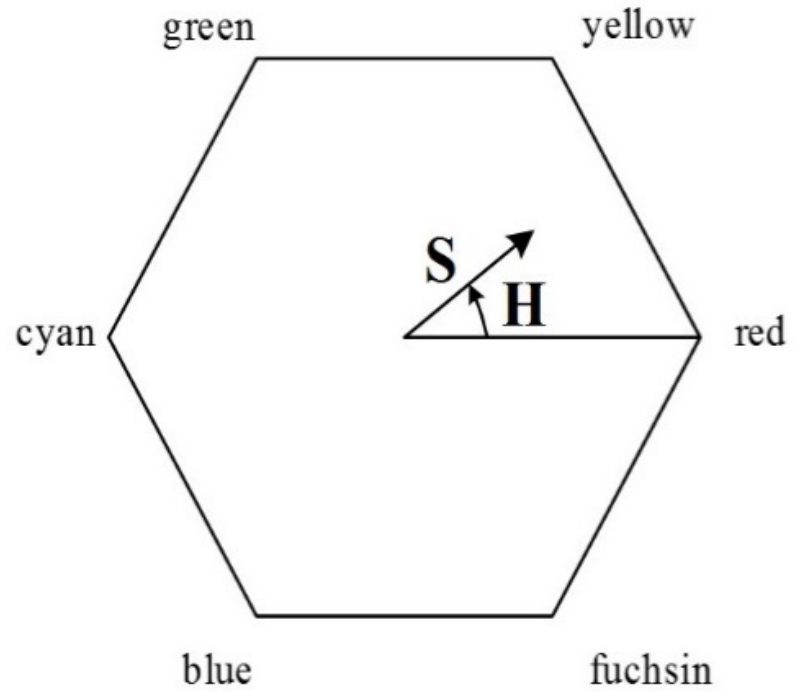
Figure 2. HSI space model (H is the hue. S is the saturation).